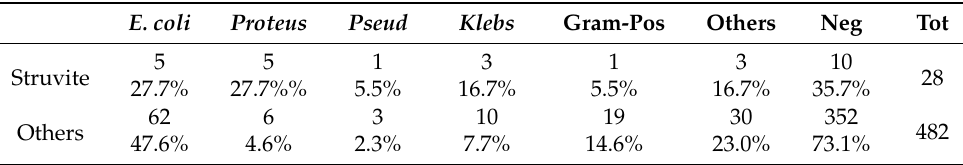
Table 1. Spectrum of isolates associated with stones of different